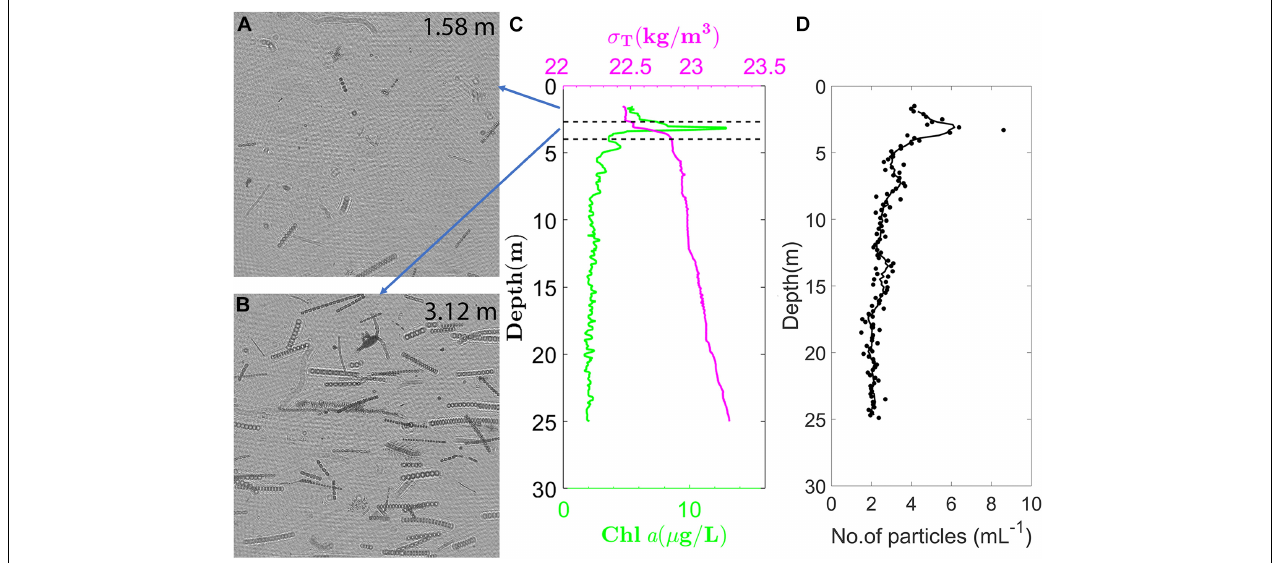
FIGURE 5 | Holographic data acquired on September 22, 2015 during a vertical profile through a diatom thin layer at East Sound, Washington. Background subtracted holograms showing the representative particle fields (A) above the thin layer at 1.58 m depth; and (B) within the thin layer at 3.12 m depth; (C) Chl a and density profiles acquired during the same profile, showing the thin layer occurred in a stably stratified region within the pycnocline; and (D) Particle distribution with depth, where only particles > 200 µ m in length and aspect ratio > 5 are considered, consisting of different elongate diatom species, and dominated primarily by Ditylum brightwelli . Figure generated from a dataset presented in Nayak et al. (2018a;